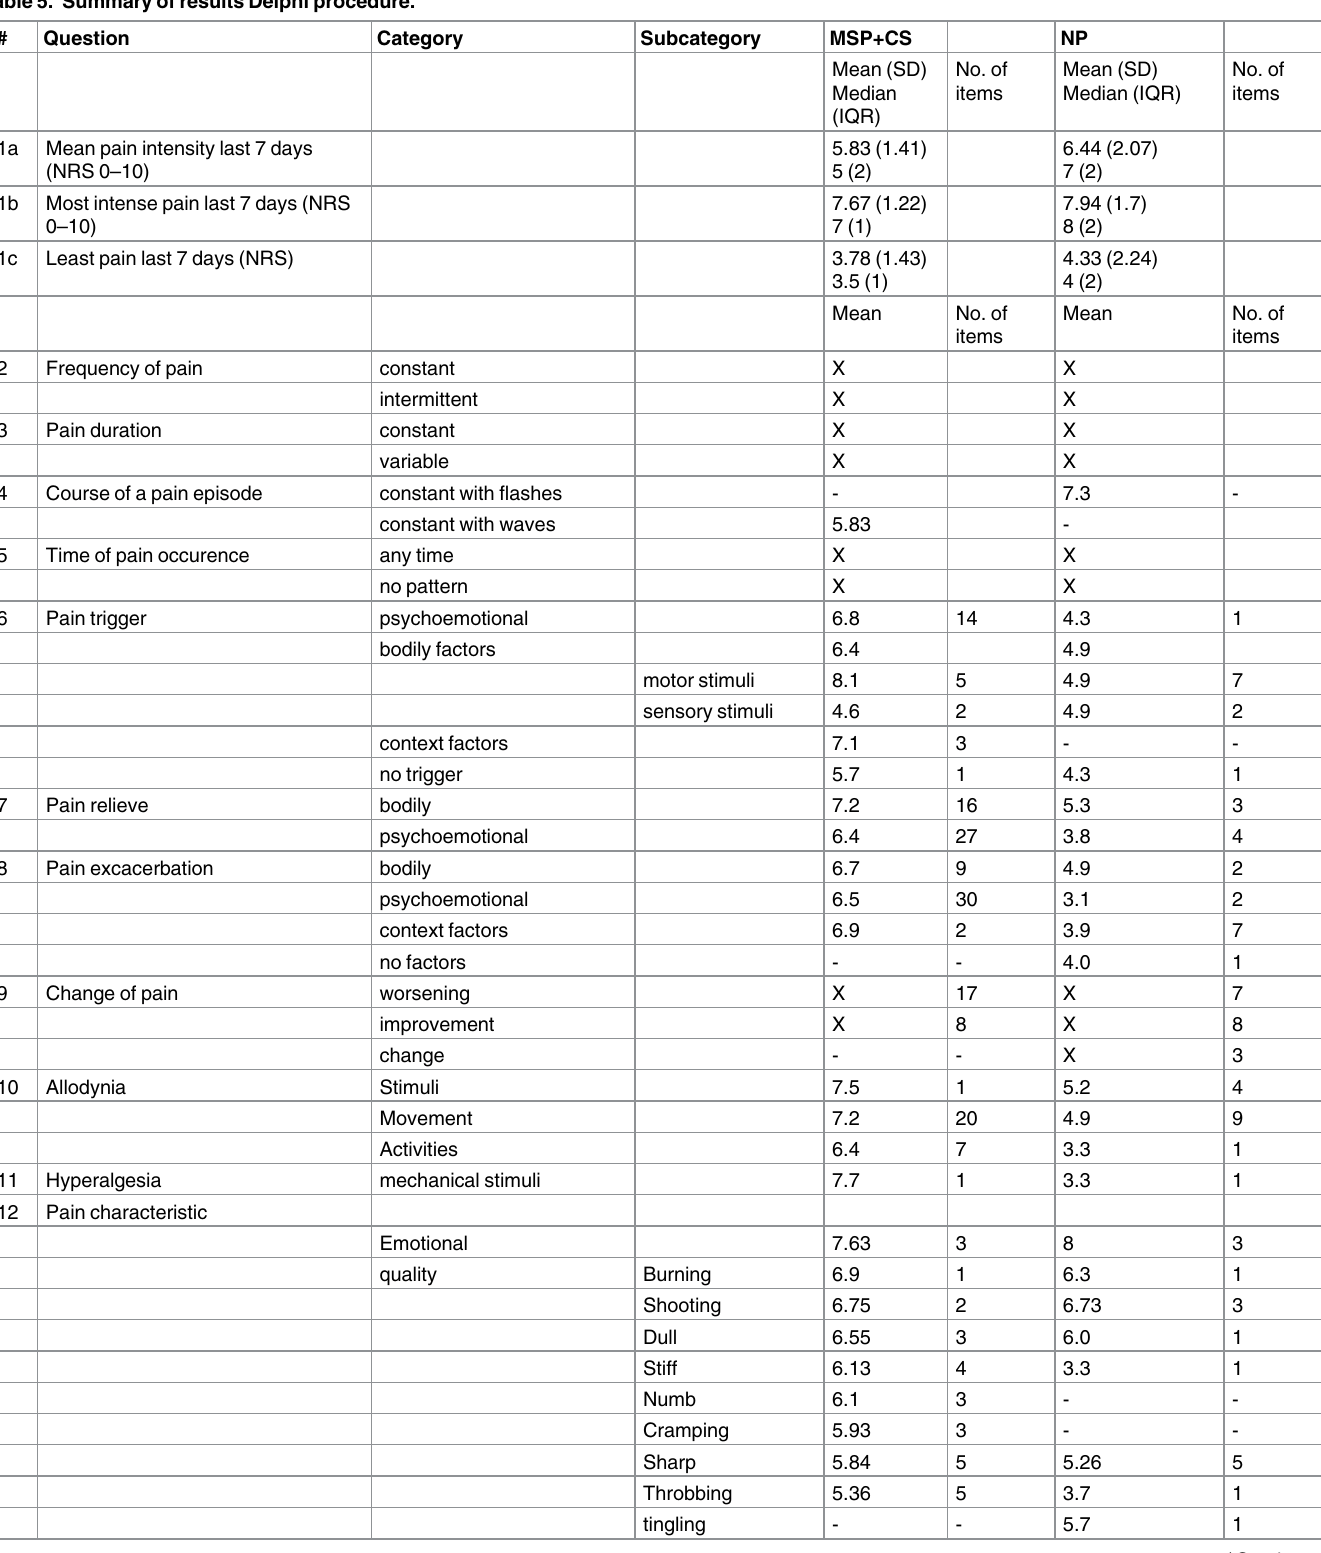
Table 5. Summaryof results Delphi